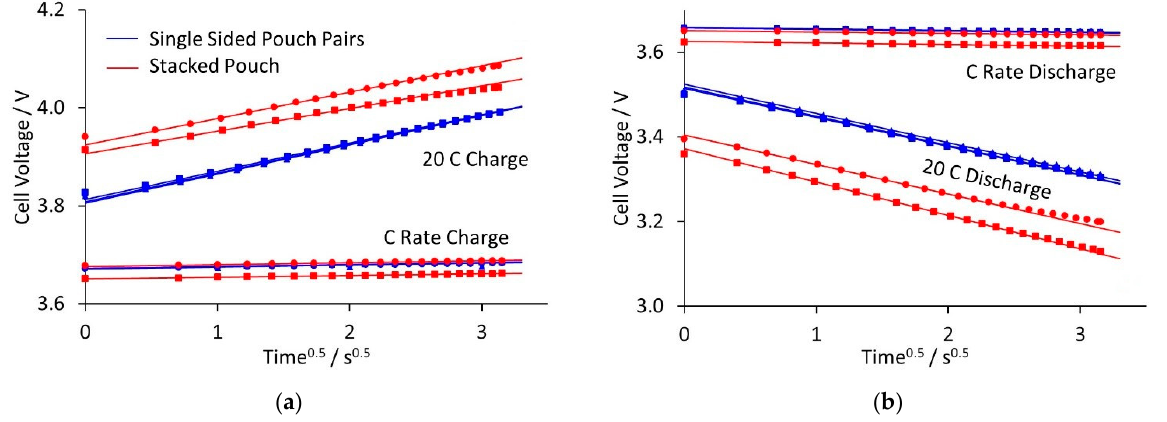
Figure 6. Cell voltages during ten second pulses for ( a ) charge and ( b ) discharge. Figure 7. Analysis of 20 C charge and discharge pulses with ( a ) initial voltage drop and ( b ) gradient during transit.